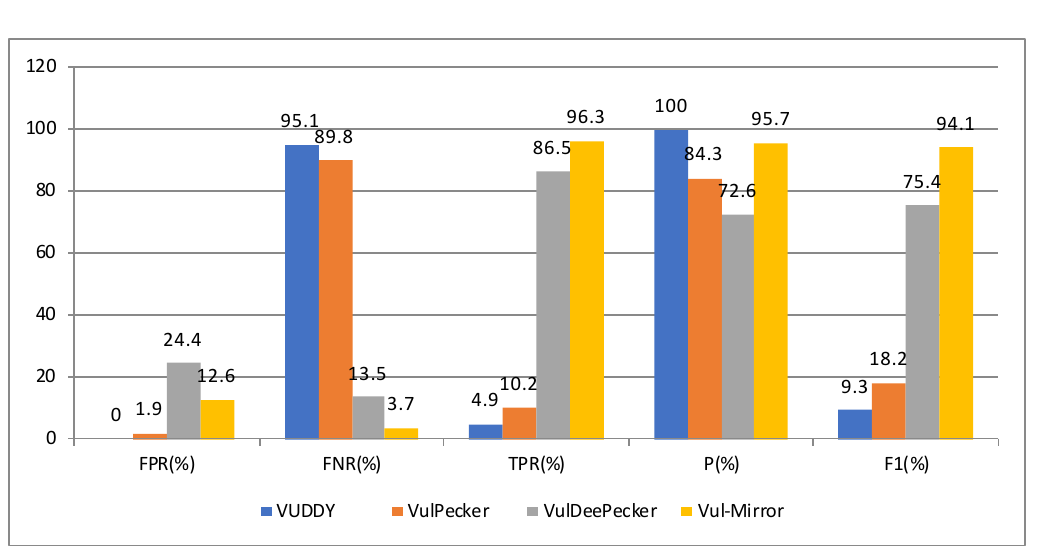
Figure 3. the results comparing to other